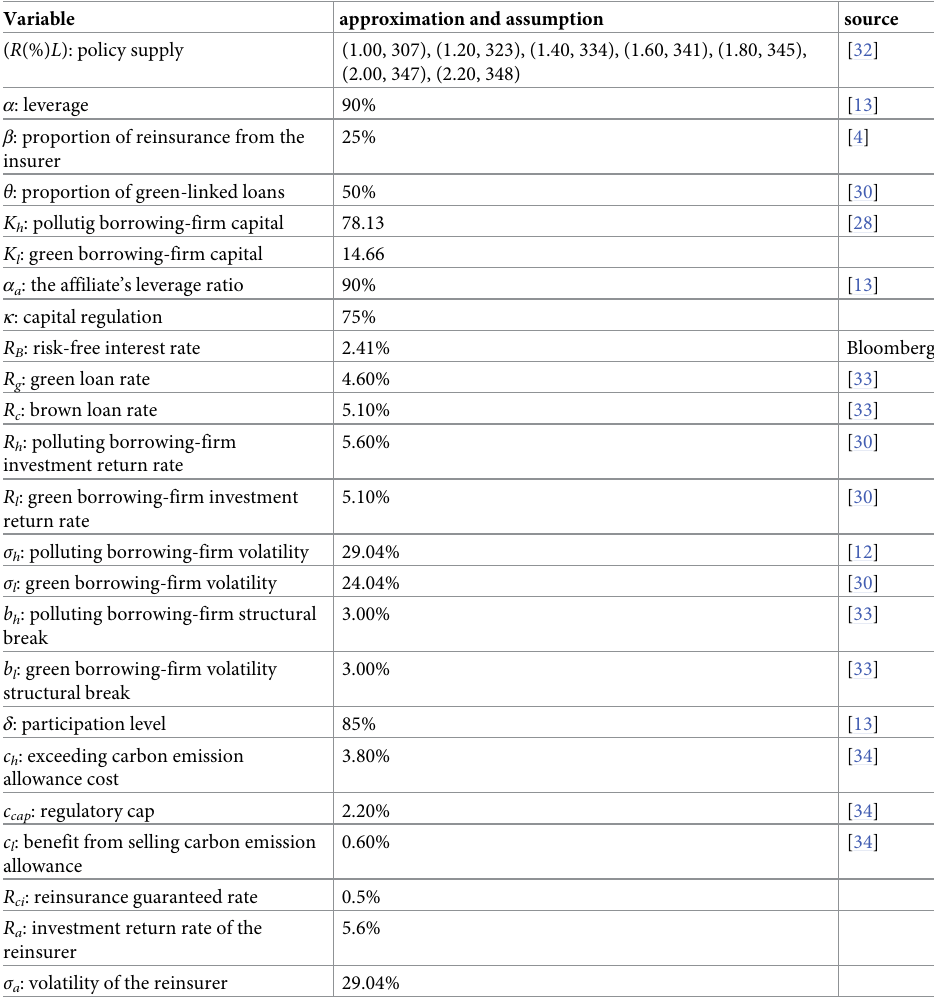
Table 2. Data description.